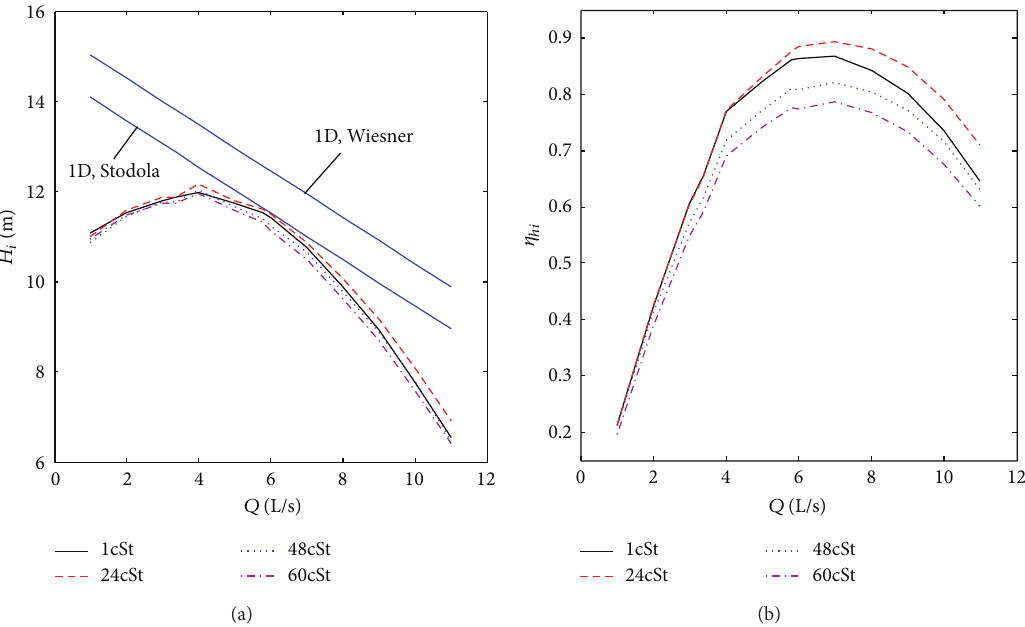
Figure 8: Impeller theoretical head and hydraulic efficiency in terms of flow rate at four viscosities and Ra = 50 𝜇 m: (a) theoretical head and (b) hydraulic efficiency.